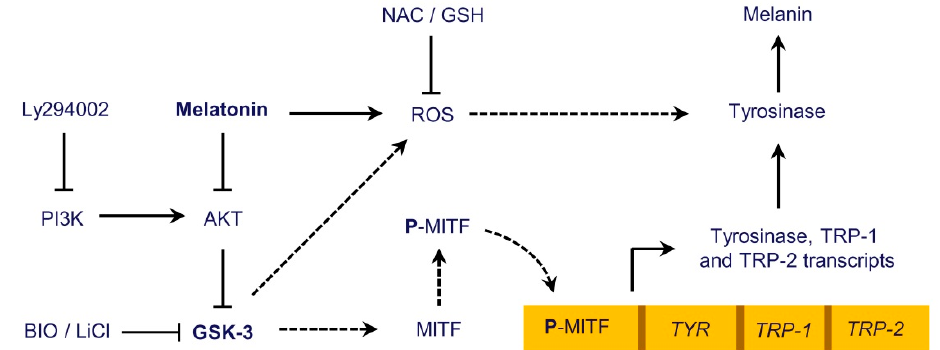
Figure 6. Schematic summary of the present study. Melatonin via PI3K/AKT pathway inhibition promotes GSK-3 β dephosphorylation (i.e., activation) which probably phosphorylates the transcription factor MITF at serine 298, enhancing its transcriptional activity. MITF binds to tyrosinase , TRP-1 and TRP-2 promoters, leading to the increase in the expression of respective transcripts. Specific inhibitors of GSK-3 β , like BIO and LiCl, block the effect of melatonin on the expression and activity of tyrosinase and on the synthesis of melanin. Melatonin also induces ROS generation that is involved in tyrosinase activity stimulation and melanin synthesis; the glycogen synthase kinase-3 β inhibitor BIO and ROS scavengers like N -acetyl-L-cysteine (NAC) and glutathione (GSH) reduce ROS formation and melanogenesis induction. The PI3K specific inhibitor Ly294002 reproduces the effect of melatonin on GSK-3 β activation and on tyrosinase activity and melanin production.